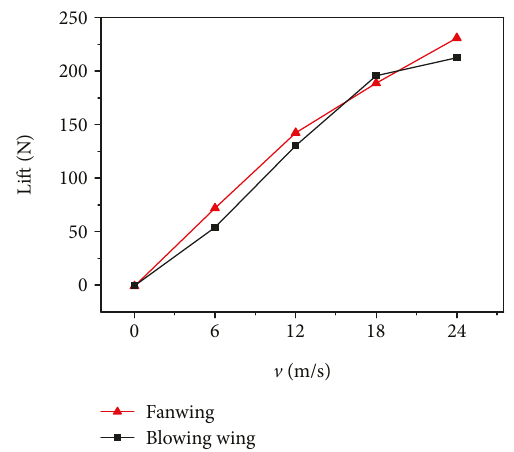
Figure 18: Lift curve changes with the forward fl ight speed.